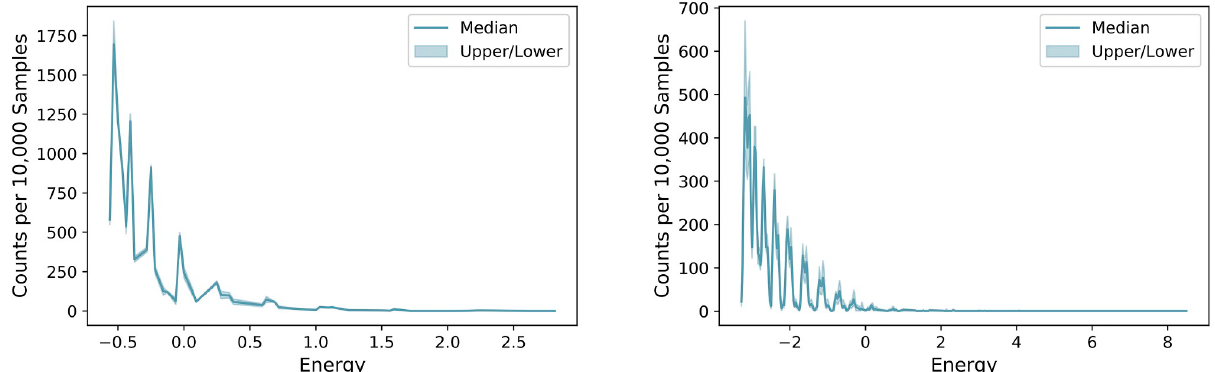
Fig 6. Number of results returned for each energy. Number of results out of 10,000 samples returned at each energy. Left: Butane ( C 4 H 10 ), Right: Heptane ( C 7 H 16